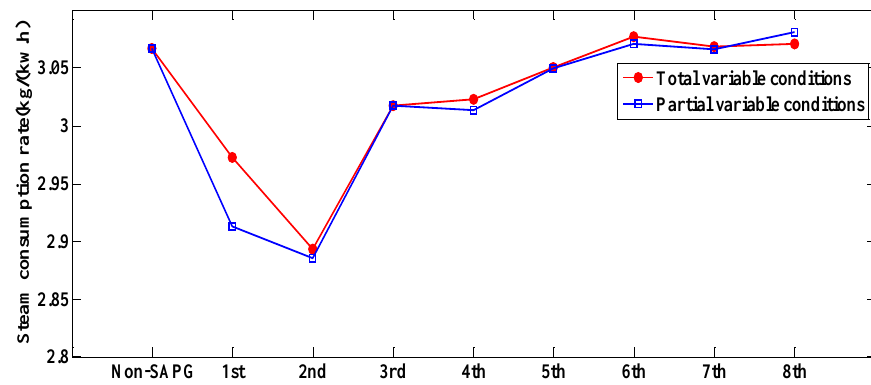
Figure 8. Replace each stage of the steam consumption rate.